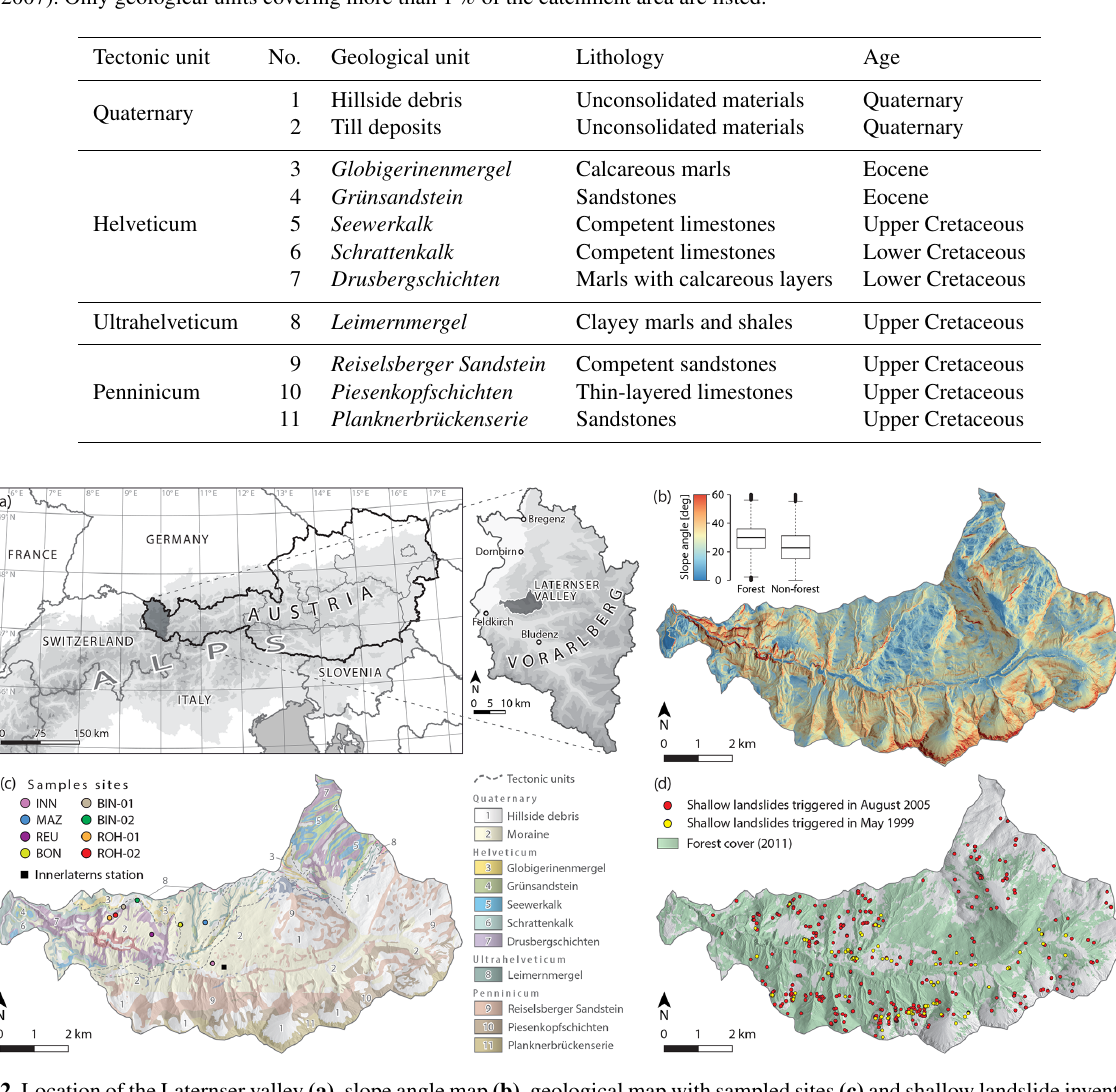
Table 1. Information on the geological units shown in Fig. 2c and their respective lithology (Heissel et al., 1967; Oberhauser, 1958, 1982; Friebe, 2007). Only geological units covering more than 1% of the catchment area are listed.